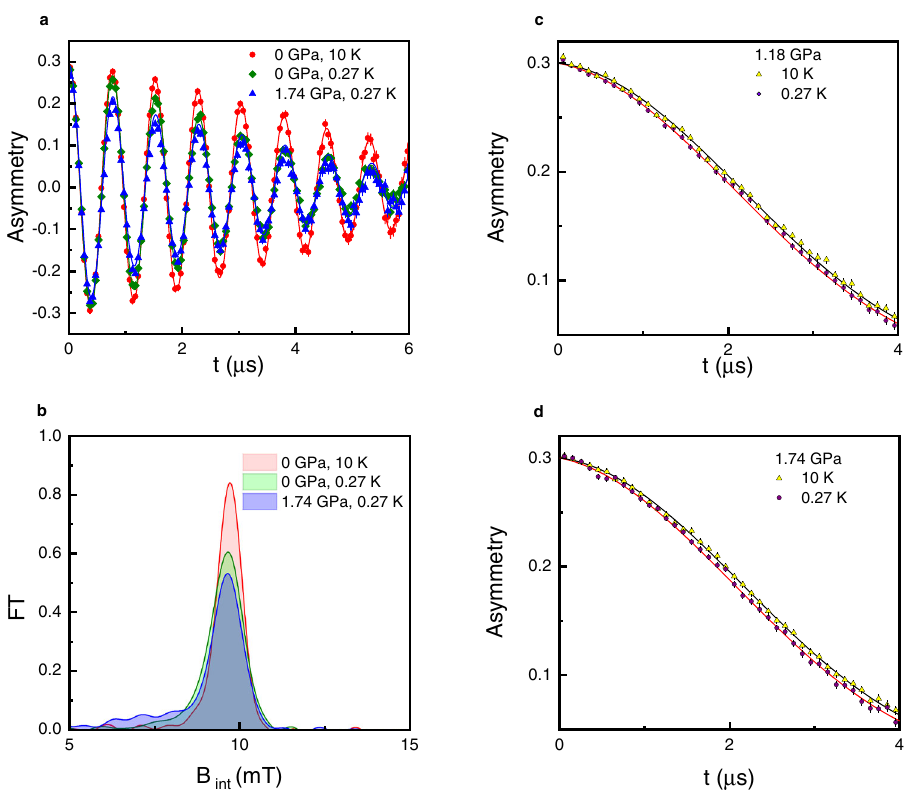
Fig. 1 Transverse fi eld (TF) and zero fi eld (ZF) muon spin rotation/relaxation time spectra. a Selected TF- μ SR time spectra at 0.27 K (in the superconducting state) and 10 K (in the normal state) collected for ambient and 1.74 GPa pressure. Solid lines are the fi ts of the spectra considering both the sample and background parts, as described in the Supplementary Note 2. b The Fourier transform of the spectra shows an additional broadening of the peak due to an inhomogeneous distribution of internal fi elds, resulting from the appearance of a vortex lattice. c , d Representative ZF- μ SR time